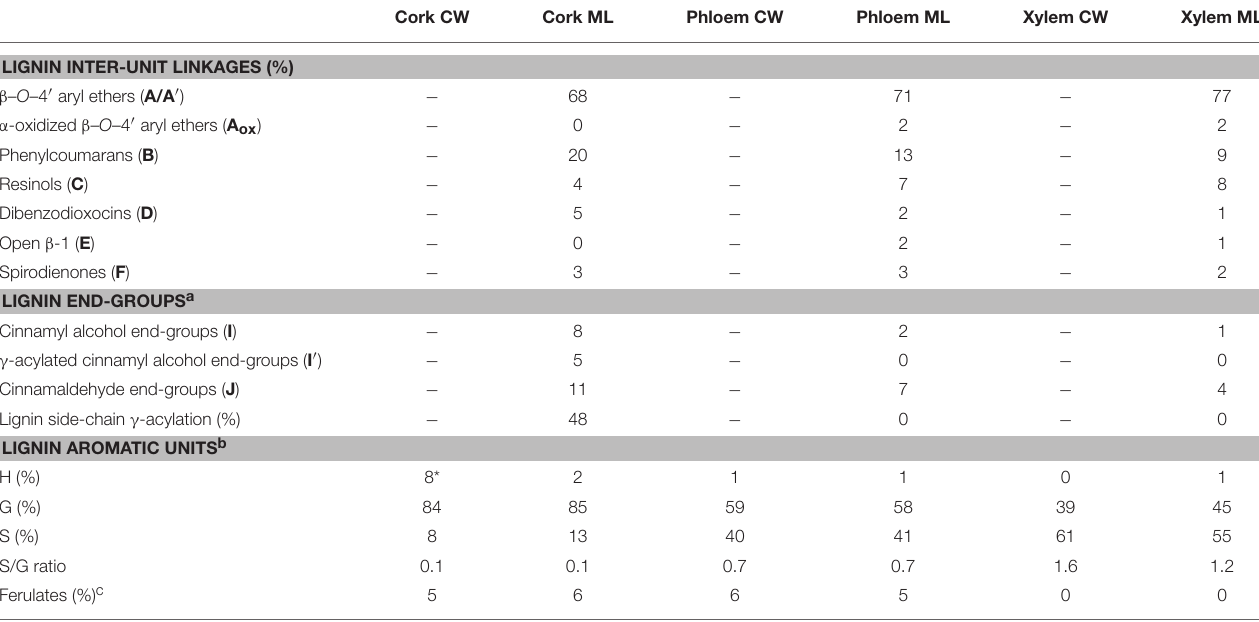
TABLE 4 | Structural characteristics (lignin inter-unit linkages, end-groups, γ -acylation, aromatic units and S/G ratio, and ferulate content) from Integration of 13 C- 1 H correlation peaks in the HSQC Spectra of the whole cell-walls (CW) and isolated milled lignins (ML) of xylem, phloem, and cork from Quercus suber L. Cork CW Cork ML Phloem CW Phloem ML Xylem CW Xylem